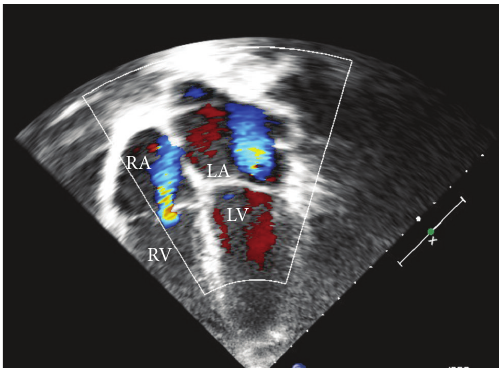
Figure 1: Apical 4-chamber view showing mitral valve (MV) and tricuspid valve (TV) regurgitations (demonstrated by the blue jets of retrograde flow on the Doppler study). Aortic and pulmonary valve regurgitations are not seen on this image.